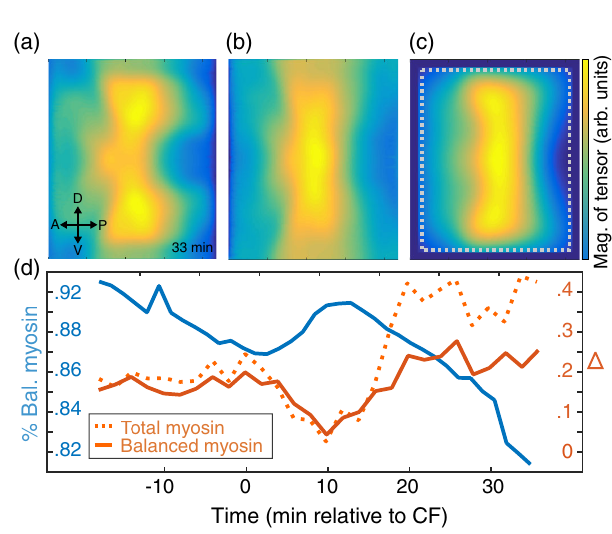
FIG. 5. Balanced myosinversus total myosin. (a) The magnitude of the myosin tensor measured in Ref. [36] 33 min after the formation of the ventral furrow. (b) Same for the balanced component myosin tensor, defined by Eq. (13), at the same time. Note that the balanced myosin is approximately constant along the DVaxis in contrast with the total myosin displayed in (a). (c) The magnitude of the inferred stress tensor at the same time point. Note greater similarity with (b) than with (a). The dotted gray box shows the region that was amenable to image segmentation. (d) The average misalignment Eq. (10) between inferred stress and myosin tensors [balanced (total) displayed as solid (dashed) orange lines]. The balanced fraction of myosin is shown in blue. As expected, the inferred stress tensor provides a better approximation for the balanced component of myosin tensor then for the